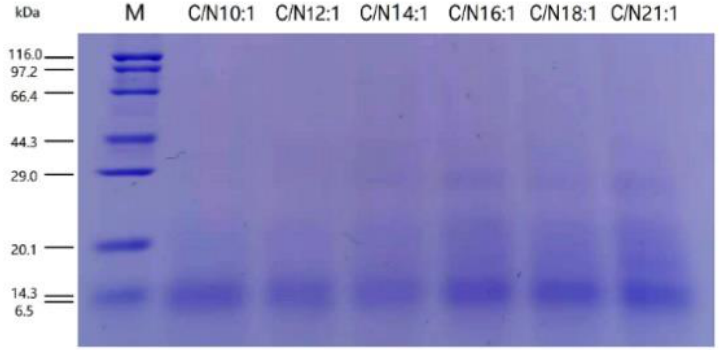
Figure 1. SDS-PAGE analysis of the resolved lyophilized AMP extracts.